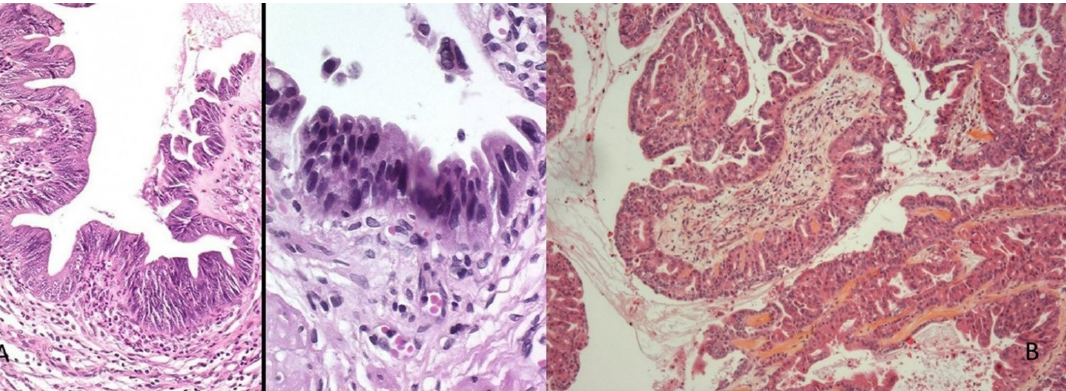
Figure 7. Biliary preneoplastic lesions: ( A ) flat high-grade biliary intraepithelial neoplasia (BilIN); ( B ) low-grade intraductal papillary neoplasia (IPBN) (HES staining ×250).